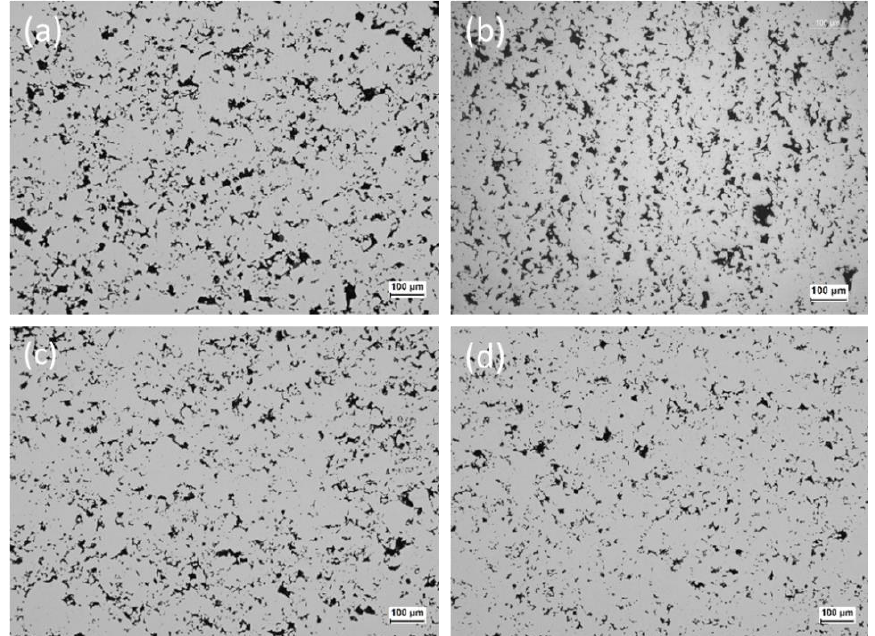
Figure 2. The morphology of porosity and sintering necks at different levels of density: ( a ) 6.75 g/cm 3 (porosity 14.23%), ( b ) 7.00 g/cm 3 (porosity 11.05%), ( c ) 7.05 g/cm 3 (porosity 10.4%), and ( d ) 7.15 g/cm 3 (porosity 9.15%).